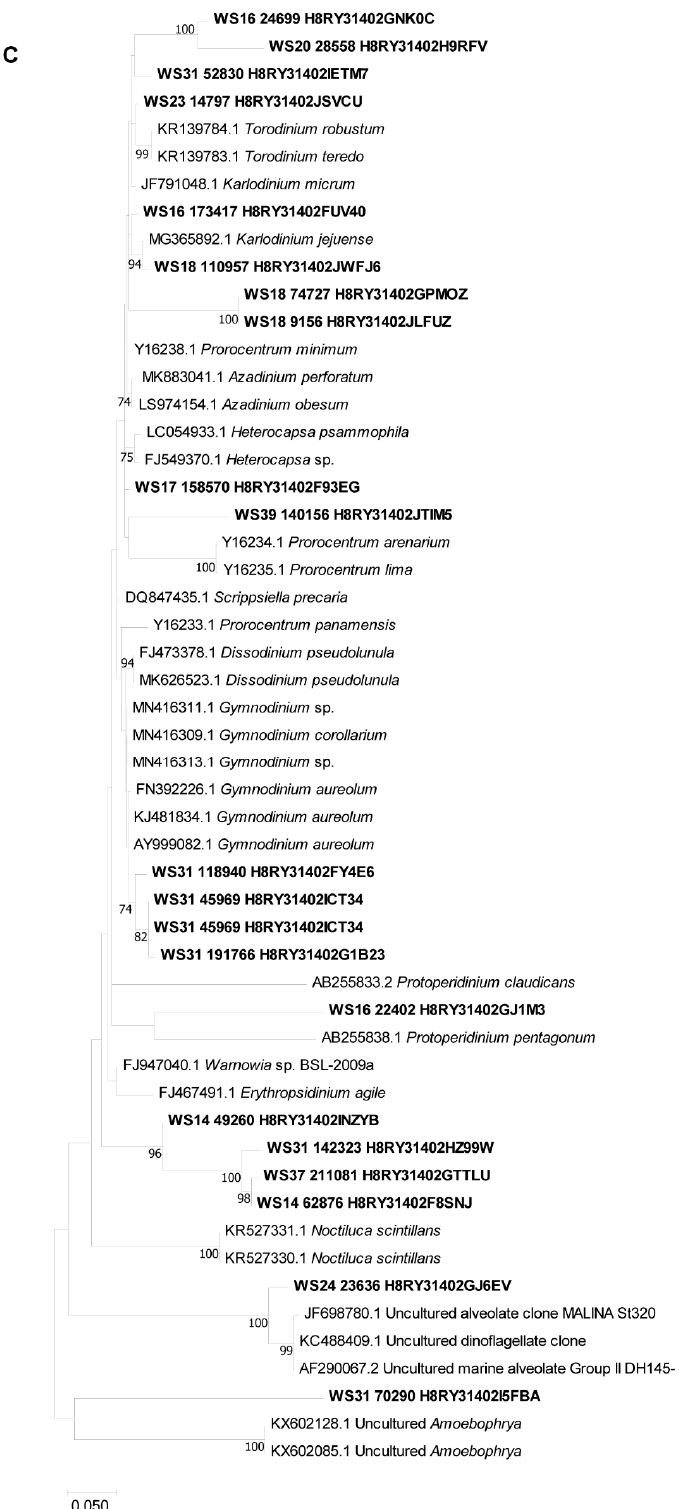
Figure 6. Maximum Likelihood phylogeny of OTUs belonging to MAST group ( A ), haptophytes ( B ) and dinoflagellates ( C ). Bootstrap support of 75 is shown by branches. Bold type indicates OTUs from this